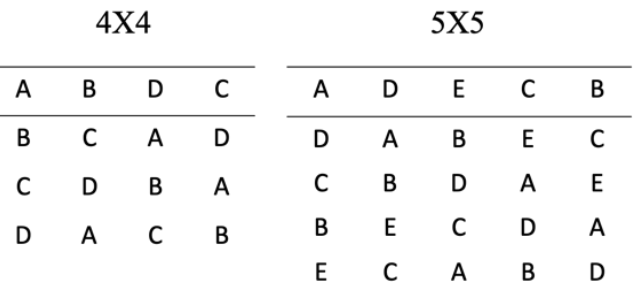
Figure 3. Latin square of each treatment is repeated n times so that it appears once in each row.